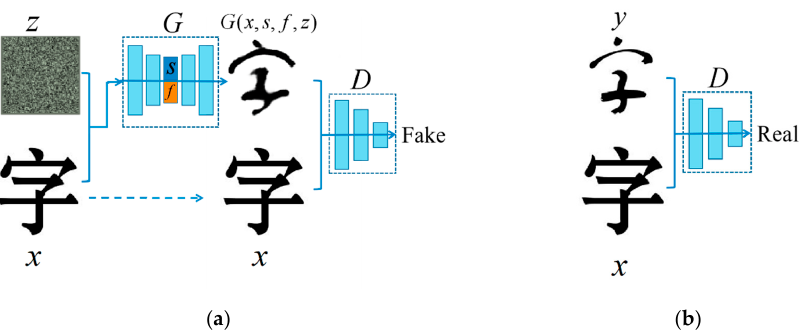
Figure 4. The training procedure of the font generation module. ( a ) The generator, G, tries to generate high-quality images to fool the discriminator; ( b ) the discriminator, D, is trained to recognize the generator’s outputs as well as possibilities. The font generation module is trained by paired images (consists of source font images x and target domain images y that are ground-truth).